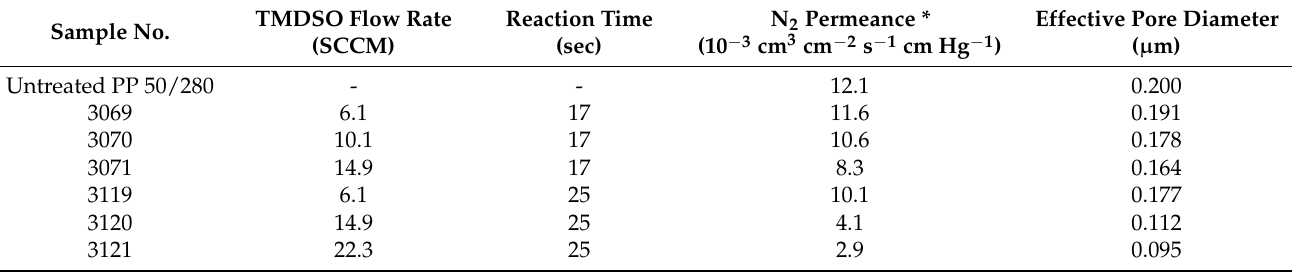
Table 2. Effect of monomer flow rate and reaction time on N 2 permeance (PP50/280).